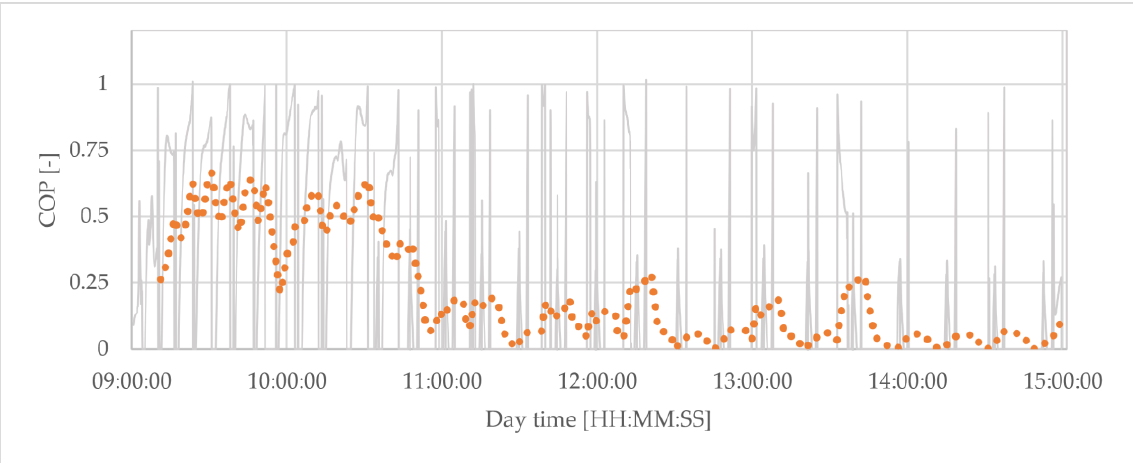
Figure 14. COP values over time for 31st July.